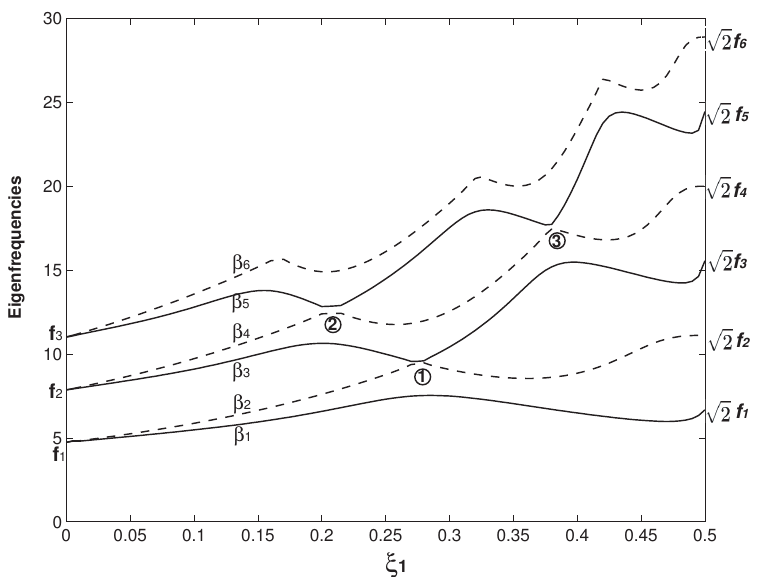
Figure 8. The first six eigenfrequencies ( β n , n = 1–6) as the functions of the overhang length ( ξ 1 ) for two identical beams, i.e., m 1 = m 2 and E 1 I 1 = E 2 I 2 . The dimensions of the two overhangs are also set the same as L 1 = L 2 , b = b ∗ = 6 b 1 = 6 b 2 and h = h ∗ = 2 h 1 = 2 h 2 . Compared with the dimensions of Figure 2, the overhang thickness is doubled. The corresponding dimensionless parameters are α = α ∗ = 12, γ = γ ∗ = 48 and ∆ 1 = ∆ 2 = 0,